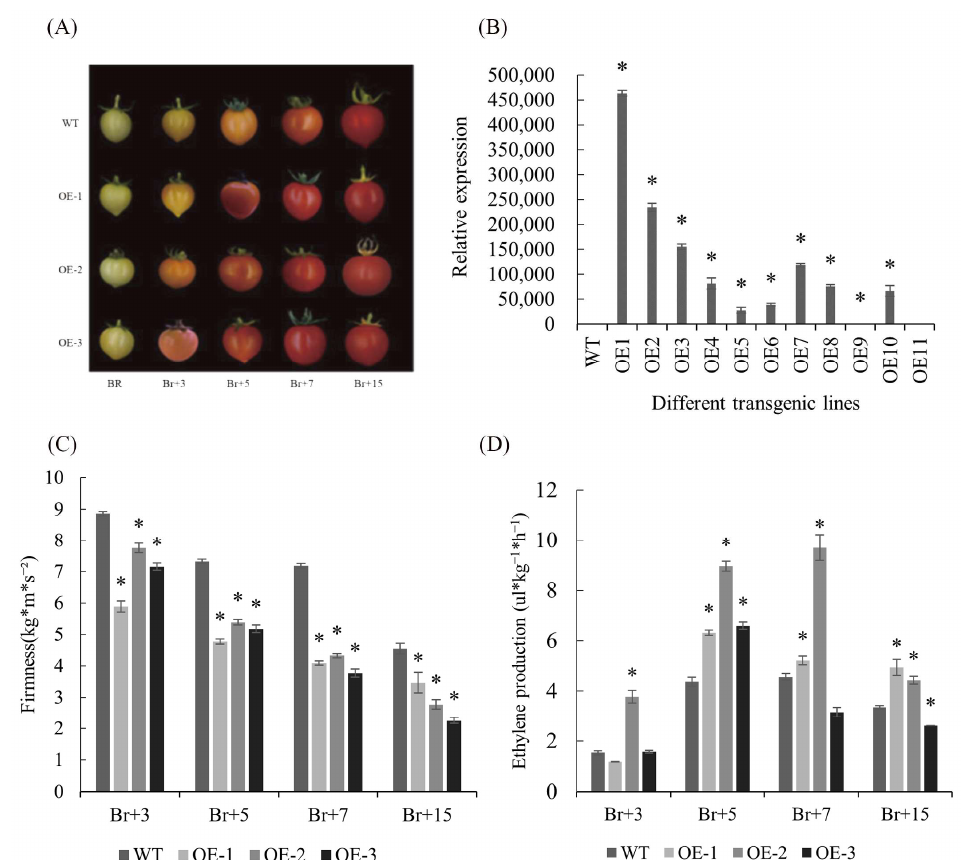
Figure 6. Influence of overexpression of VvPL11 on tomato fruit firmness and ethylene production. ( A ) Phenotypic changes of WT and VvPL11 -OE (lines OE-1, OE-2, and OE-3) during fruit developing. ( B ) RT-qPCR analysis of VvPL11 in transgenic plants and wild type ‘Micro-Tom’ tomato. ( C ) Fruit firmness. ( D ) Ethylene production. Data were shown as the means ± standard deviation. * represent significant differences at p < 0.05.